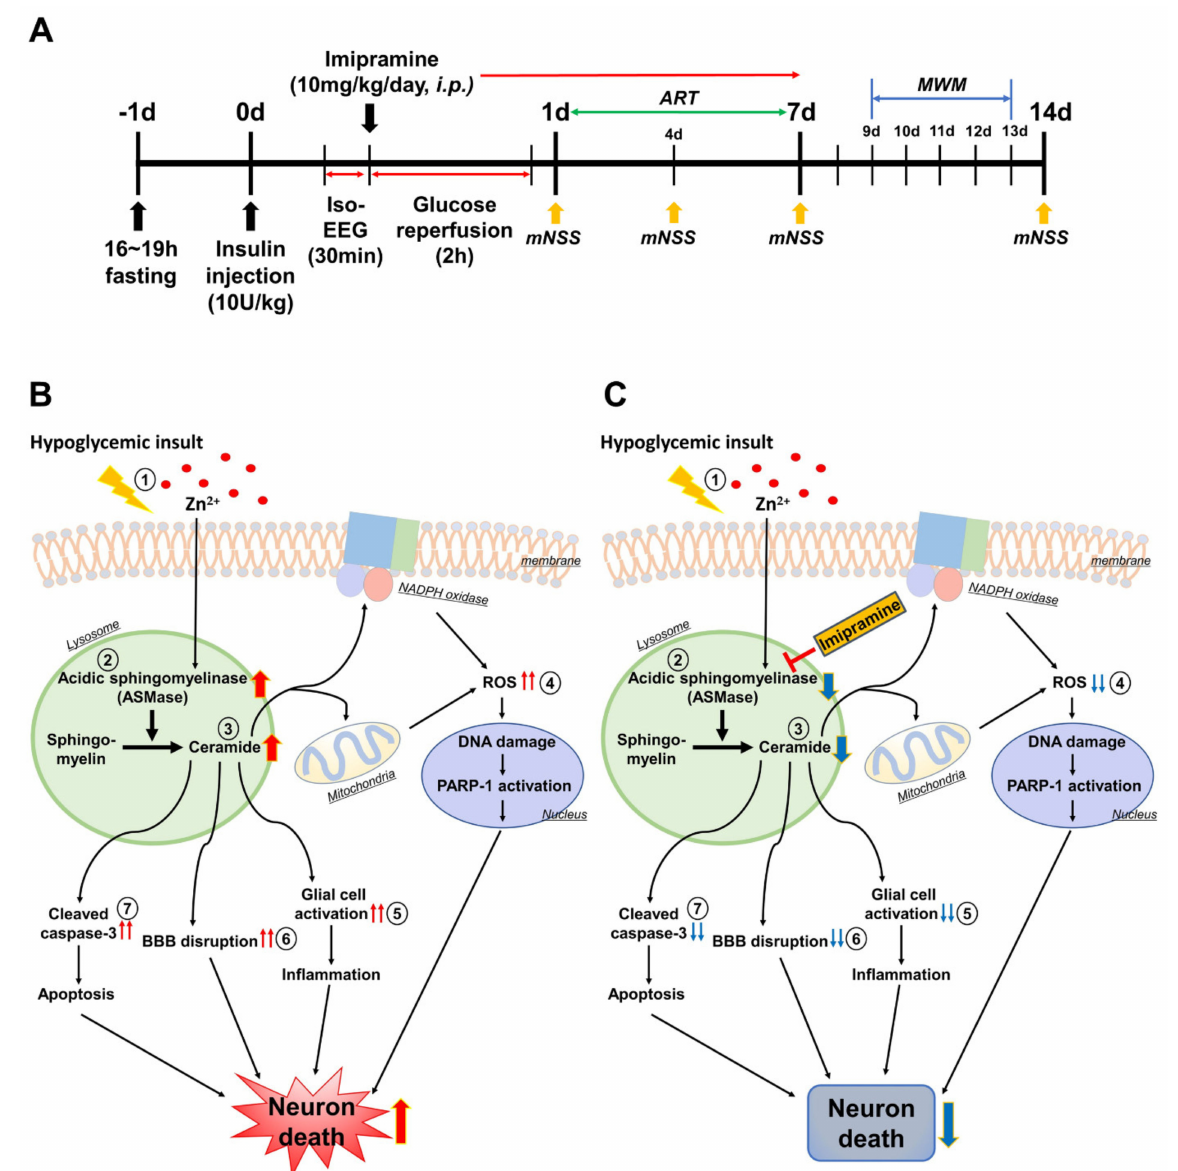
Figure 8. Possible association of ASMase, ceramide, and neuronal death under hypoglycemia/glucose reperfusion conditions. This schematic illustration explains the effects of imipramine on the process of the hypoglycemia-induced neuronal death mechanism. ( A ) Experimental timeline. ( B ) Hypoglycemia- induced neuronal death mechanism: ( 1 ) after hypoglycemia, excessive zinc release and translocation from pre-synapse to post-synapse; ( 2 ) the excessive zinc activates ASMase abnormally; ( 3 ) the activated ASMase decomposes sphingomyelin into ceramide; ( 4 ) the increased ceramide acts on the mitochondria and NADPH oxidase, increasing ROS production; ( 5 ) the increased ceramide activates glial cells, causing inflammation; ( 6 ) the increased ceramide causes blood–brain barrier disruption; ( 7 ) the increased ceramide increases capase-3, resulting in apoptosis. When these conditions dominate, neuronal death is more likely to occur severely. ( C ) The effects of imipramine on hypoglycemia- induced neuronal death. The administration of imipramine can inhibit excessive ASMase activation and then ceramide production. Therefore, there is a possibility that imipramine can prevent neuronal death after